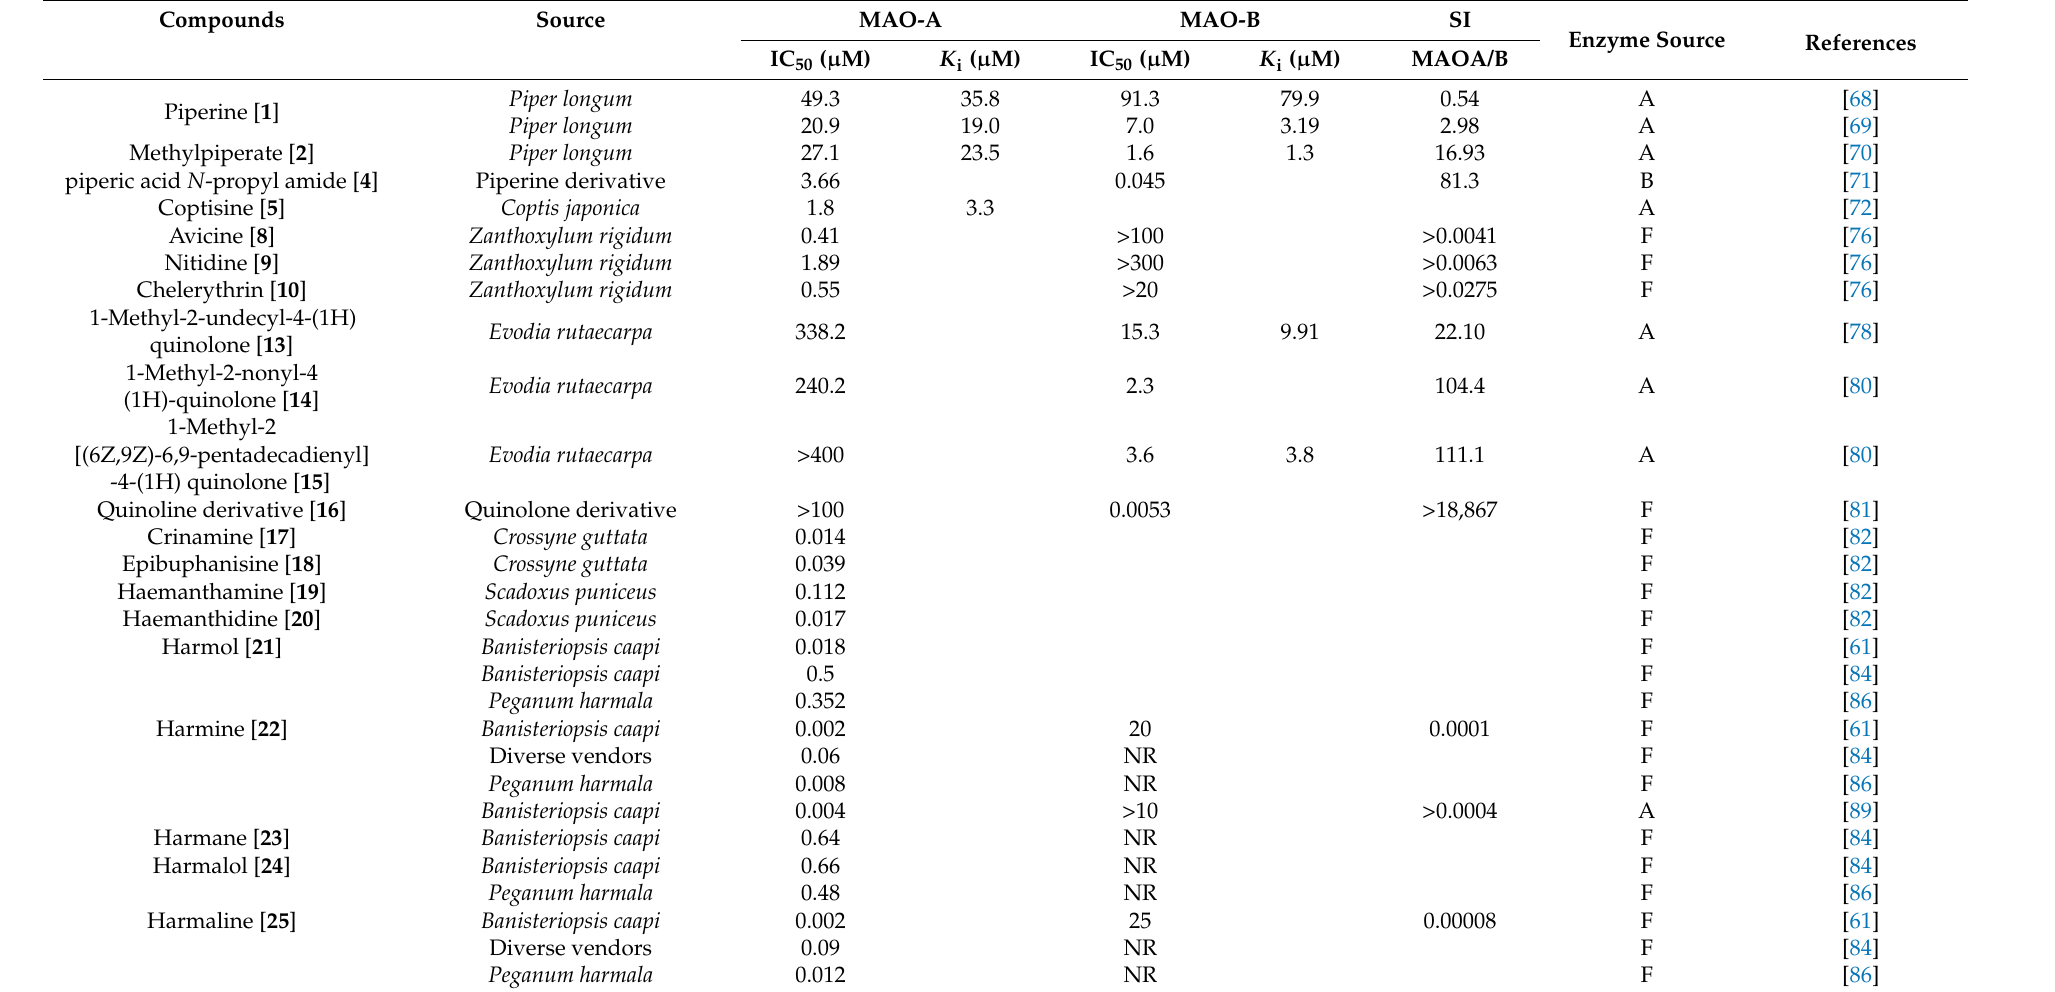
Table 2. Alkaloid natural product inhibitors of MAO-A and